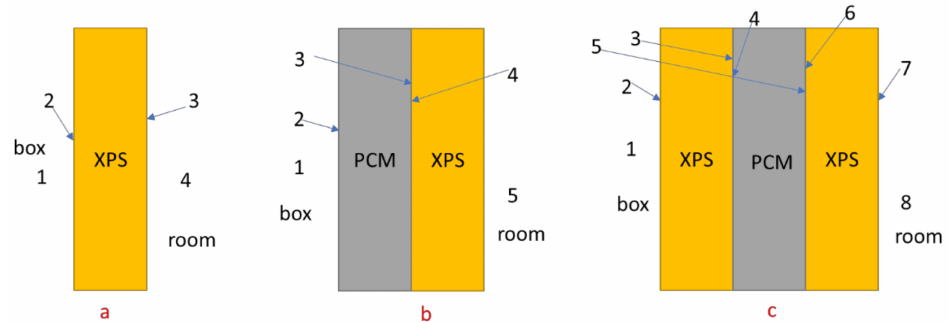
Figure 5. Measured positions of the temperature sensors for one layer ( a ), two layers ( b ) and three layers ( c ).